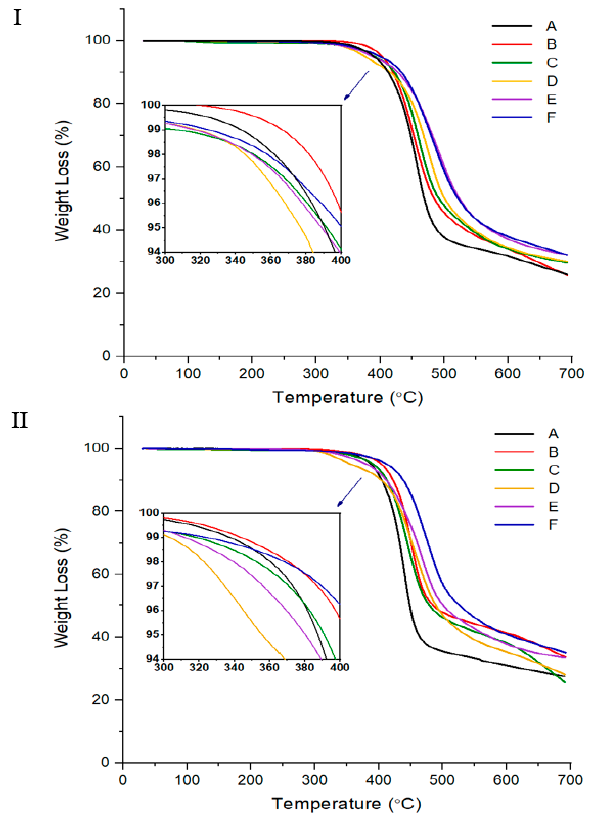
Figure 3. TGA thermograms of TLCP-I and TLCP-II series.